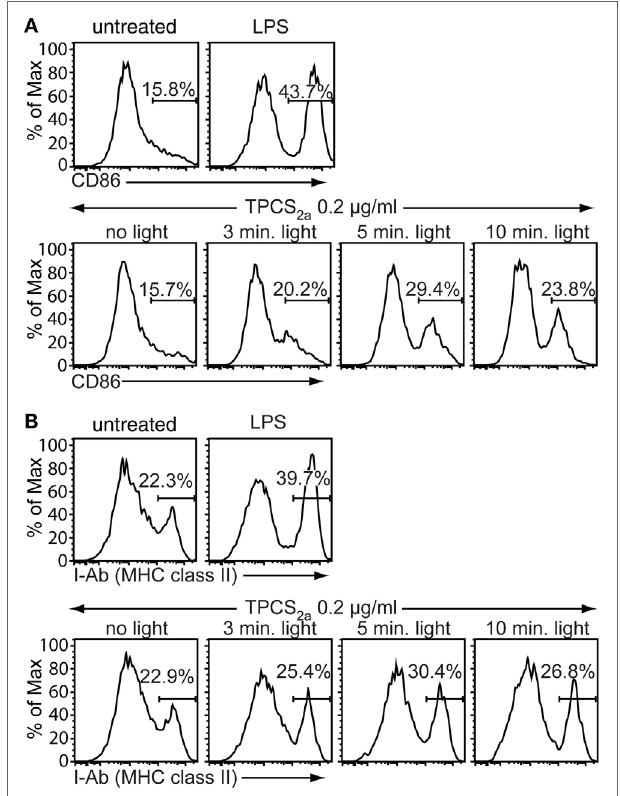
FigUre 2 | Photochemical internalization treatment promotes maturation of dendritic cells (DCs). Primary immature bone marrow-derived dendritic cells (BMDCs) were incubated for 18 h in the dark with 0.2 µg/ml TPCS 2a , 100 ng/ ml lipopolysaccharide (LPS) or were left untreated. TPCS 2a -treated cells were washed and incubated in TPCS 2a -free medium for additional 4 h before illumination for 0, 3, 5, and 10 min with blue light. Expression of the DC maturation markers CD86 (a) and MHC class II (B) on CD11c-gated BMDCs was analyzed 18 h post illumination by flow cytometry ( y -axis: % of maximum count). Shown is one representative experiment of three experiments with comparable